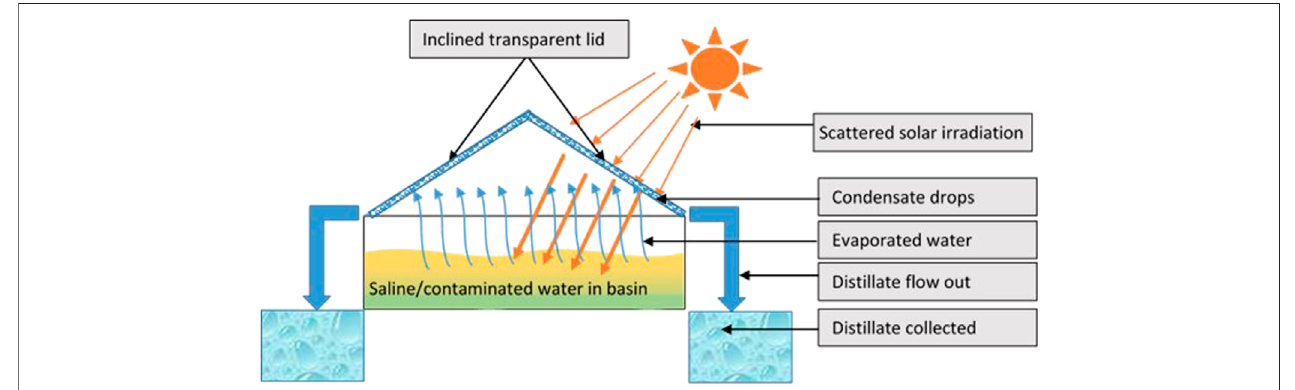
FIGURE 1 | Working Principle of a double-sloped solar